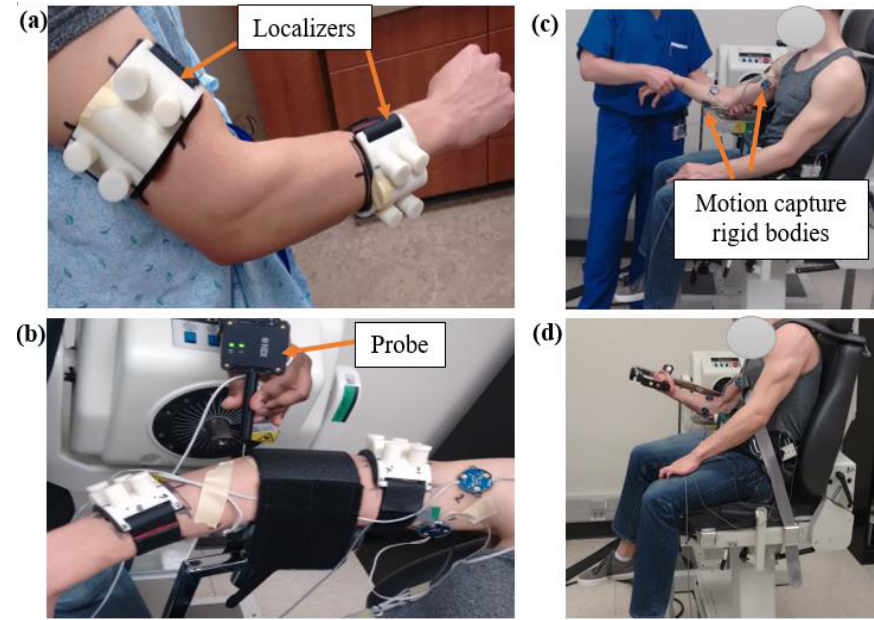
Figure 1. Experimental measurement: ( a ) Two plastic localizers attached to subject upper and lower arm; ( b ) Initial position collection using Optotrak probe; ( c ) The experimenter manipulating the arm for laxity test; ( d ) The subject performing the experimental trial.